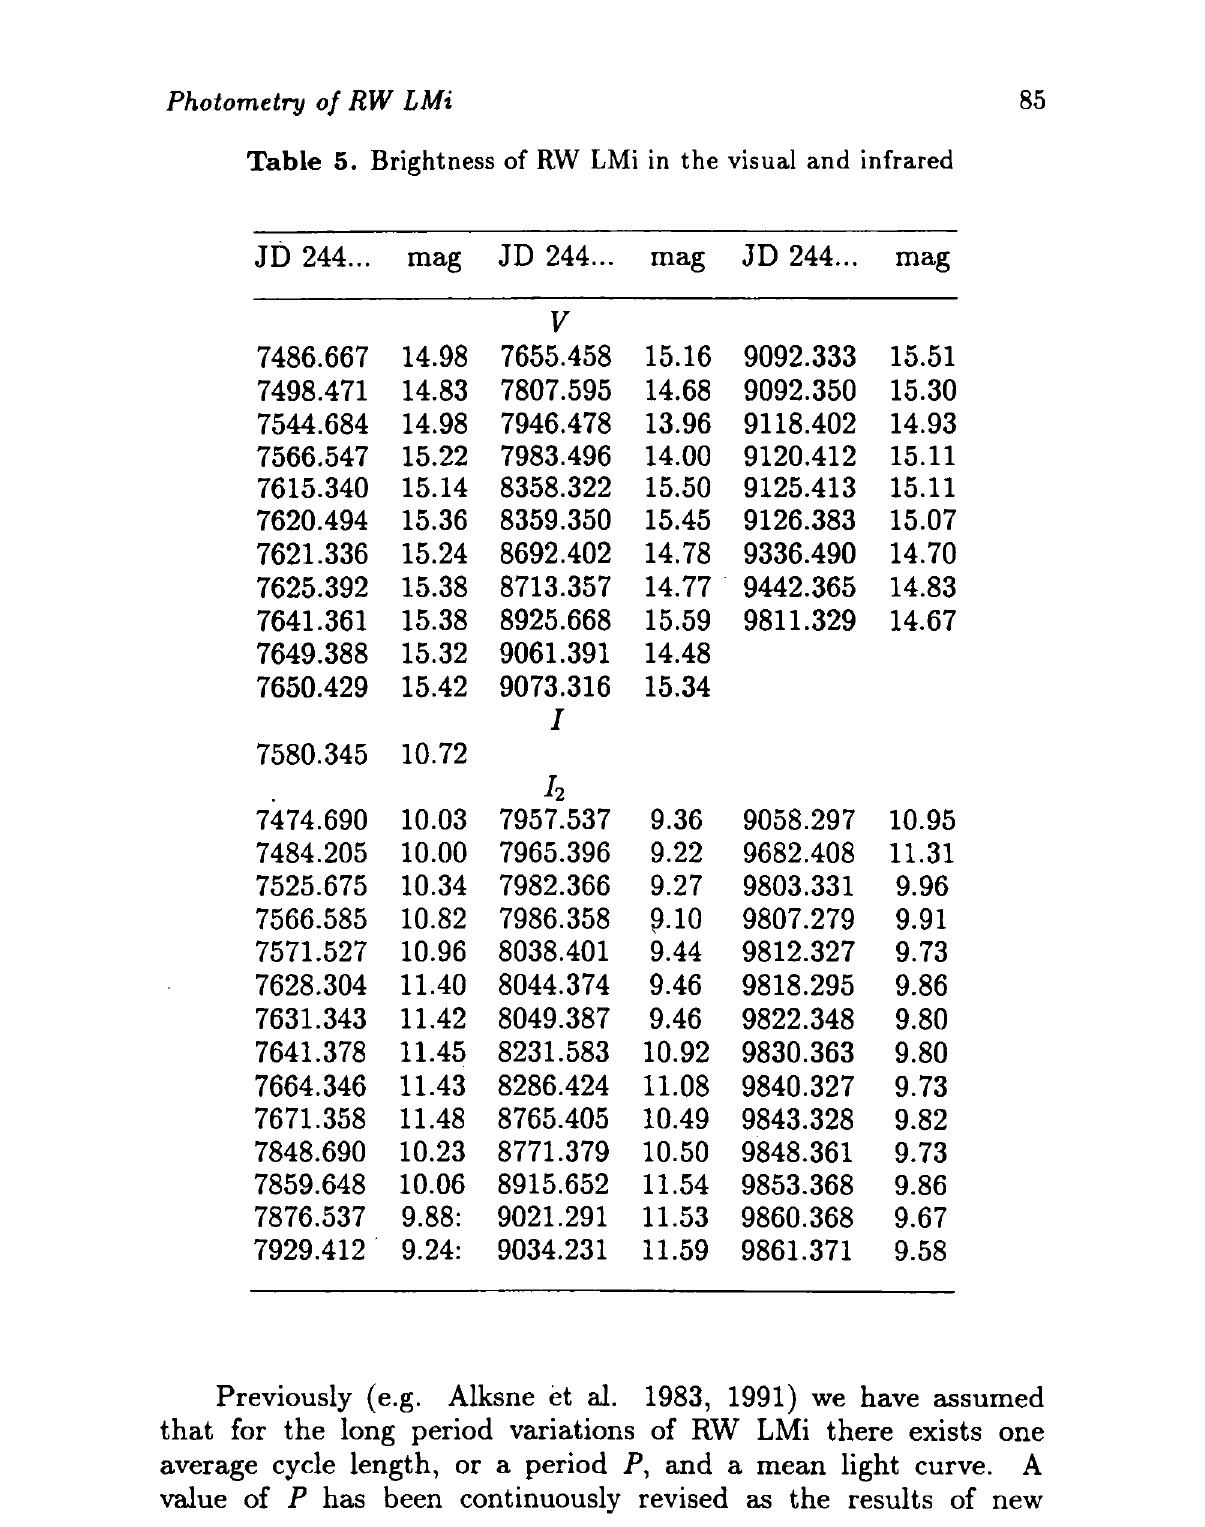
Table 5. Brightness of RW LMi in the visual and infrared